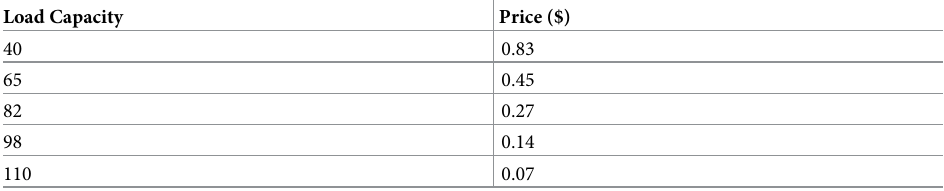
Table 6. Price strategy for the hosts based on available